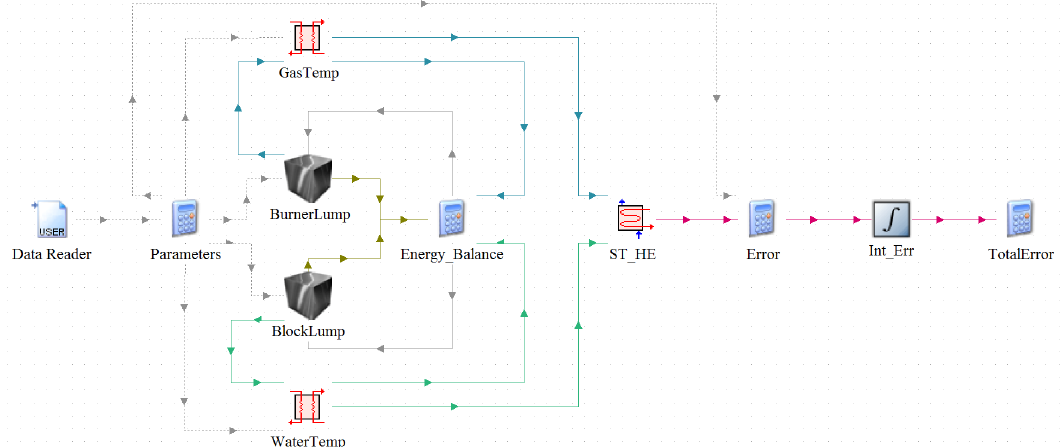
Figure 4. Layout of the Trnsys simulation combining the three